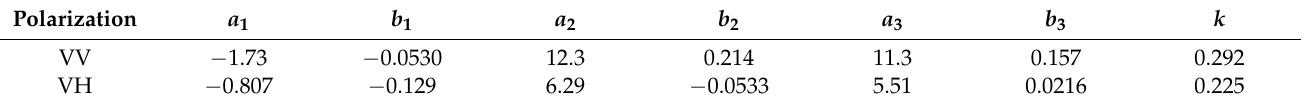
Table 3. The empirical coefficients for Equation (4).